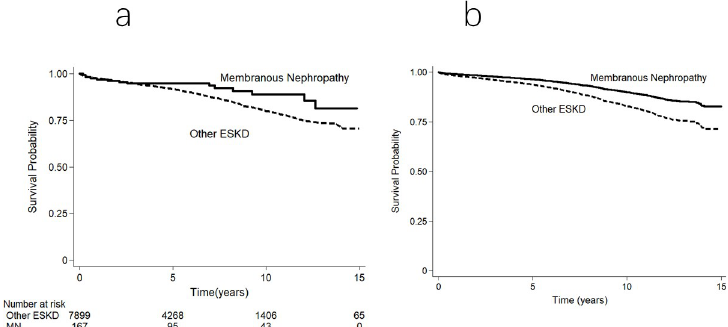
Fig 4. Transplant patient survival curves for individuals undergoing first kidney transplantation for ESKD in Australia and New Zealand. (a) Unadjusted Kaplan–Meier survival curve. (b) Survival curve adjusted for demographic, comorbidity and allograft indices. The difference between the 2 groups was significant in the adjusted analyses (unadjusted p = 0.049; adjusted p = 0.04).